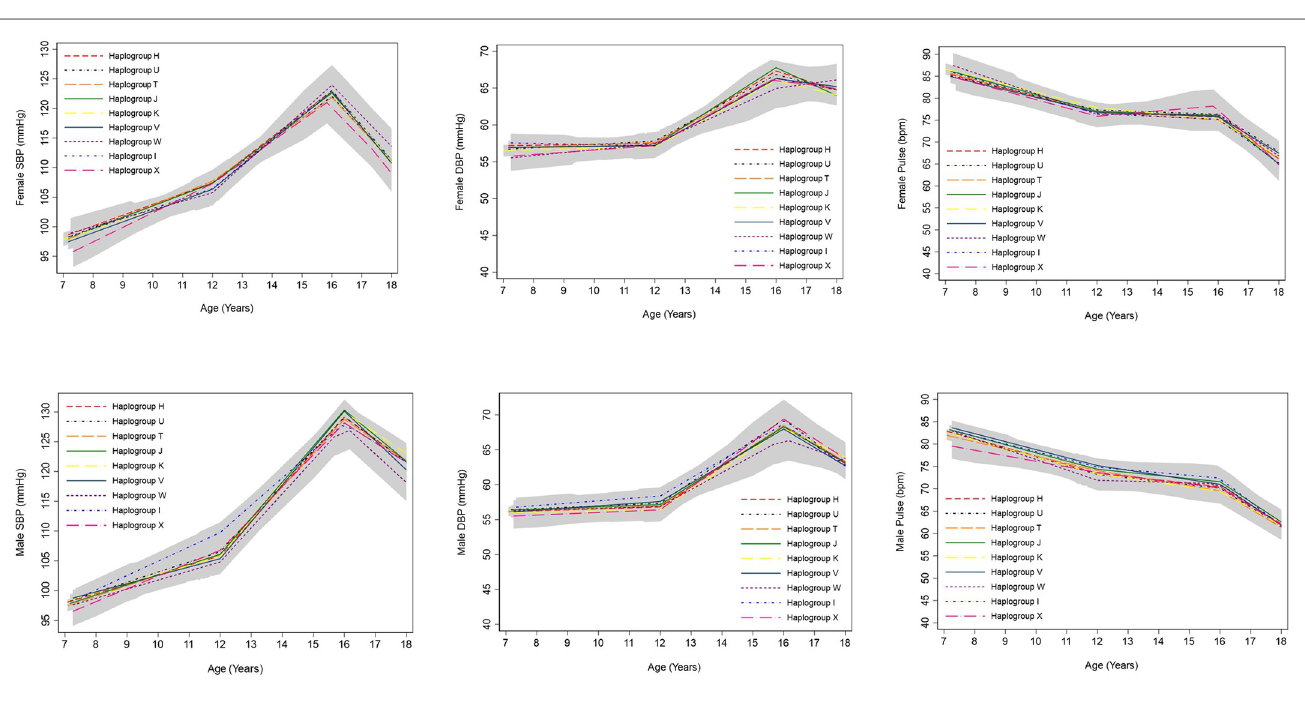
Fig 2. Mean trajectories of SBP, DBP and pulse in females and males, by haplogroup. 99% confidence intervals for all haplogroups are displayed in grey. Detailed results with confidence intervals are provided in S15 Table in S1 File. SBP, systolic blood pressure; DBP, diastolic blood pressure.